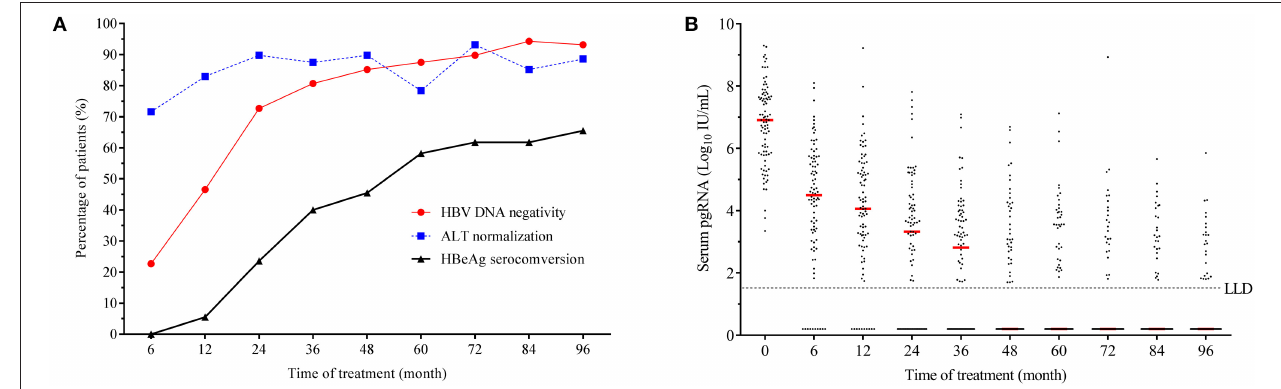
FIGURE 1 | Dynamics of clinical parameters during the 96-month NAs therapy. (A) Dynamic change in the percentages of patients with HBV DNA negativity, ALT normalization and HBeAg seroconversion. (B) Dynamic change of serum pgRNA during the 96-month NAs treatment. LLD, lower limit of detection.